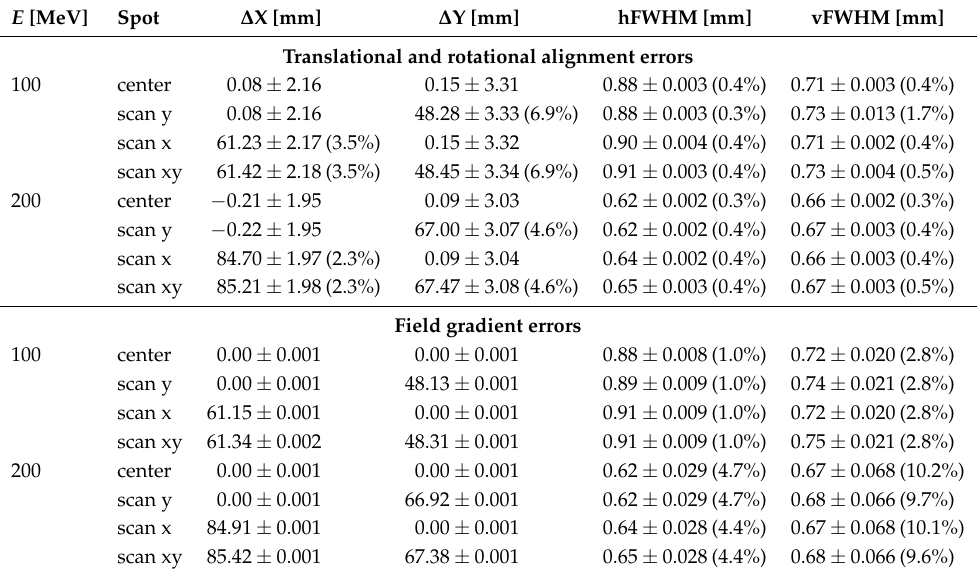
Table 3. Average values and standard deviations for the simulation of quadrupole alignment errors (top) and field gradient errors